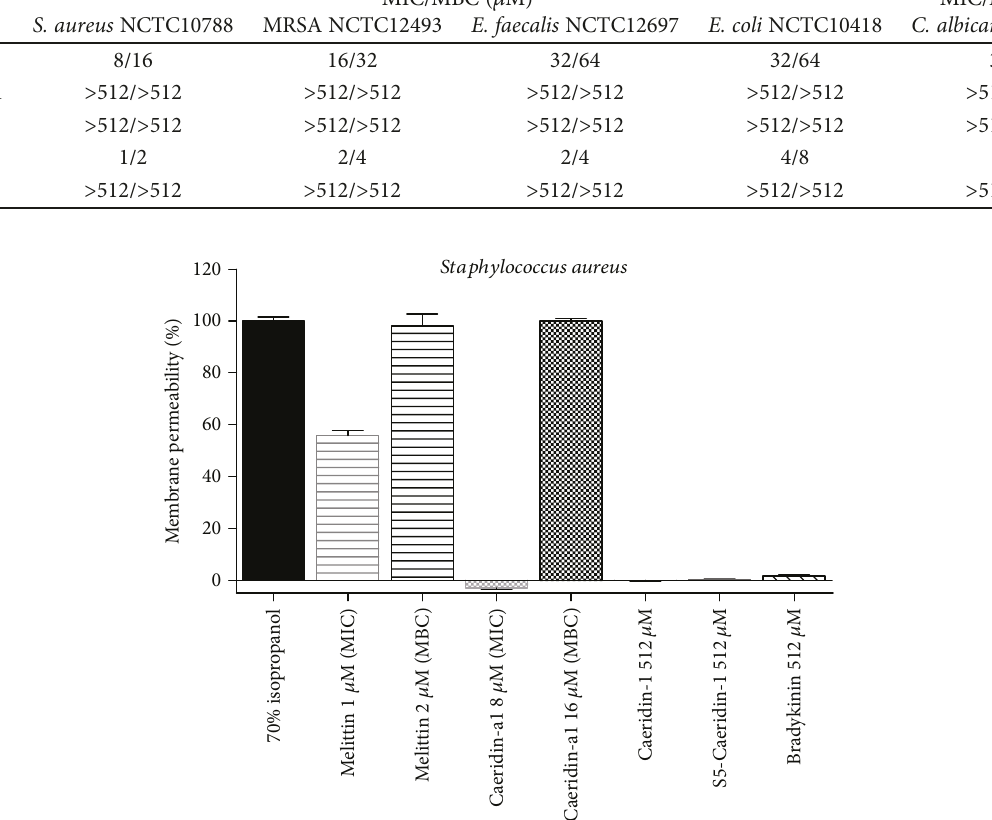
Table 4: Minimum inhibitory concentration (MIC) and minimum bactericidal concentration (MBC) of Caeridins, melittin, and bradykinin against di ff erent tested microorganisms. Peptides